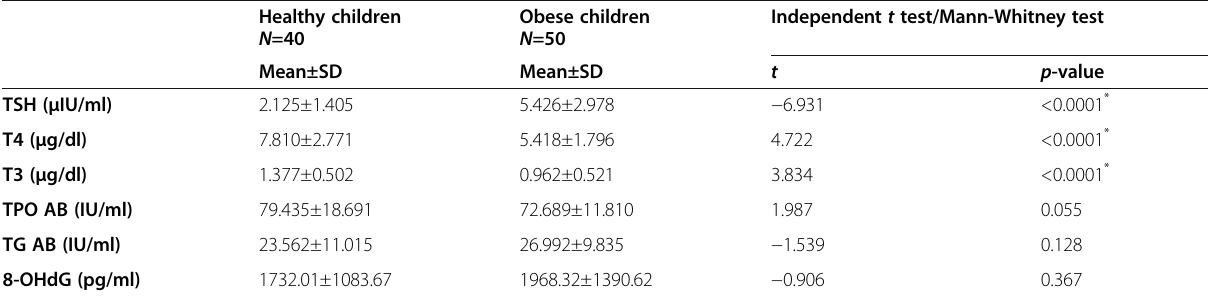
Table 1 Comparison of thyroid function, lipid profile, and oxidative DNA damage between children with obesity and healthy